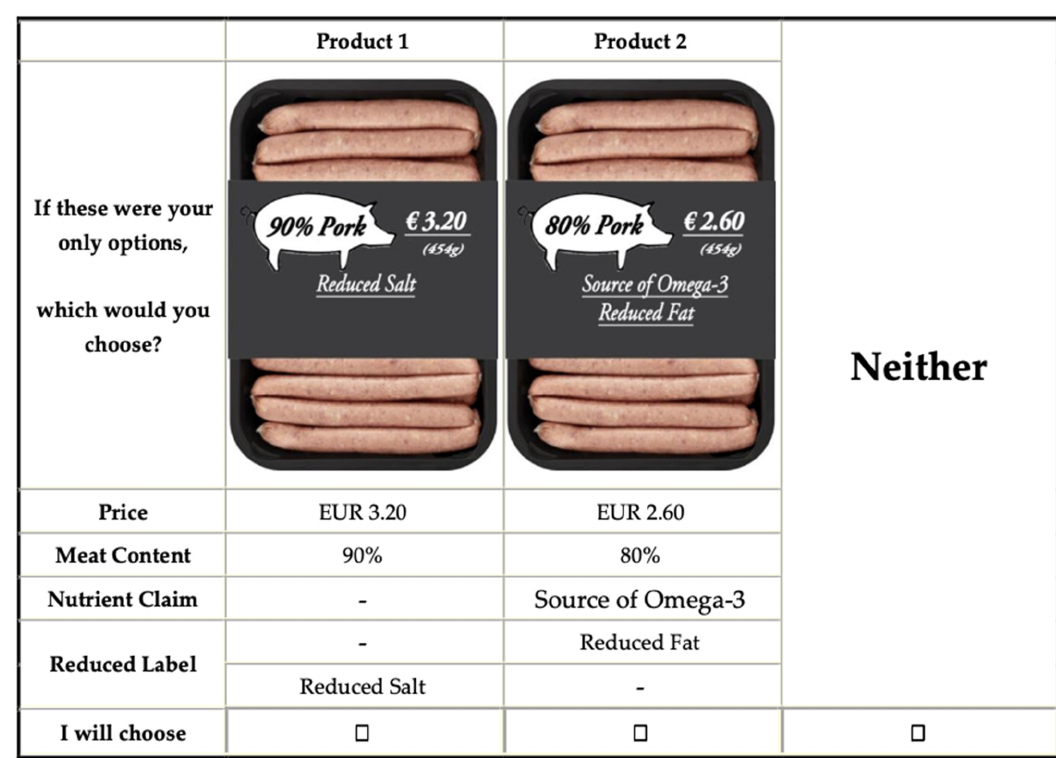
Figure A3. Choice set 3 in the questionnaire